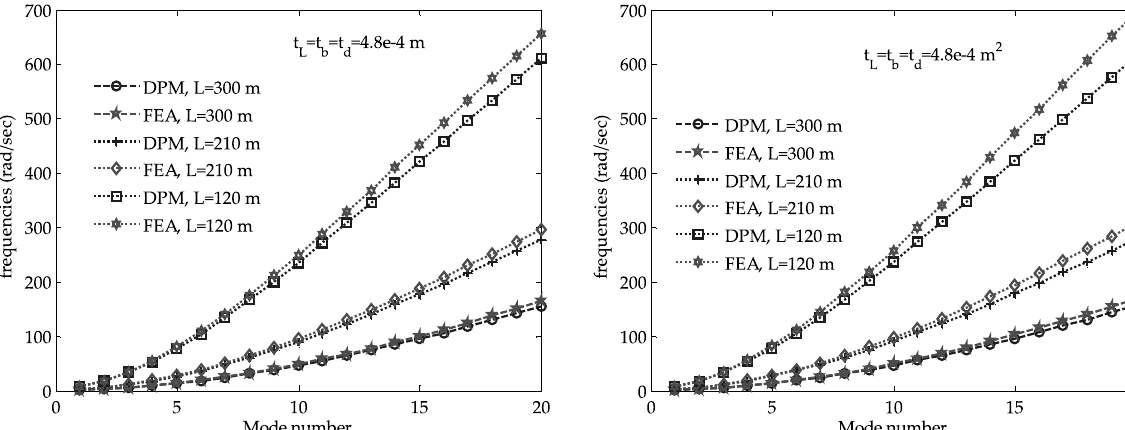
Fig. 6. Frequency comparison of DPM and FEA for satellite truss of various lengths (no actuators- con fi guration 1).